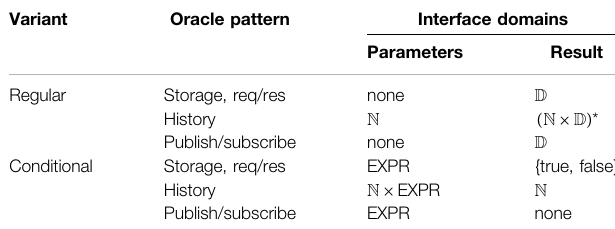
TABLE 2 | Interfaces of the oracles from the perspective of the